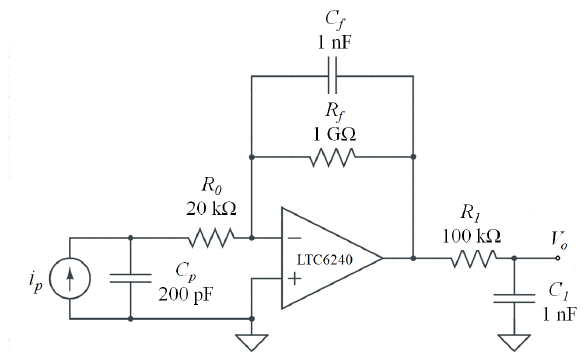
Figure 5. Overall signal conditioning circuit for the PVDF